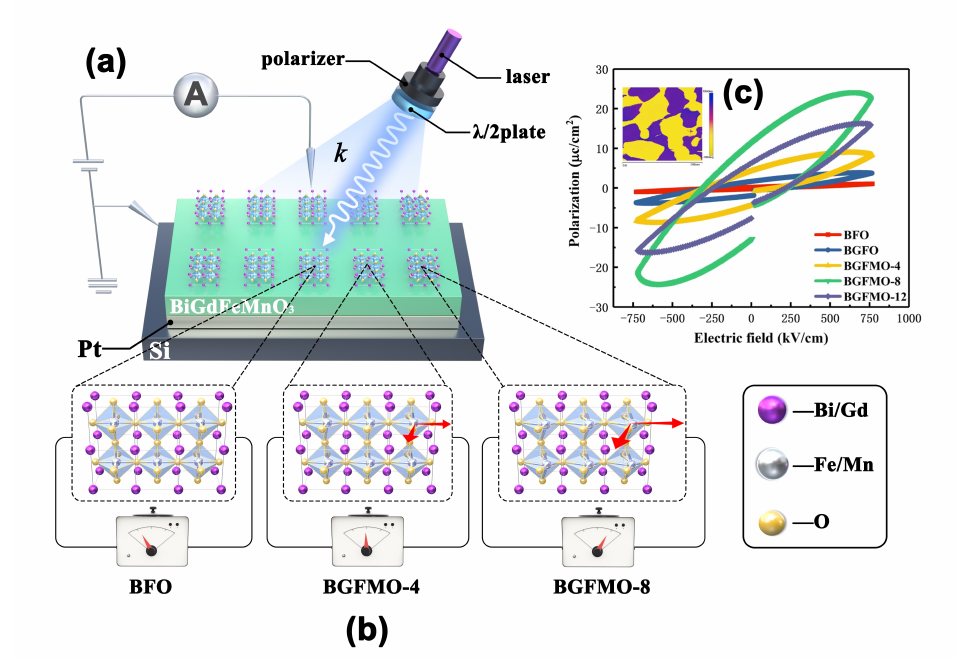
Figure 2. ( a ) Designed measurements of photoresponse under laser illumination, on samples of BGFMO on Pt/Si substrate. Ferroelectric test system is connected on the top and bottom electrode, with the blue arrow denote light propagation of wave vector k. ( b ) Illustration of increasing distor- tion/polarization (indicated by red arrows) affects on BFO, BGFMO-4 and BGFMO-8, respectively. ( c ) Electric hysteresis (P–E) loops of the pure BFO and co-doped BGFMO thin films. The inset shows a PFM measurement with a 0.5 µ m × 0.5 µ m of BGFMO-8s.